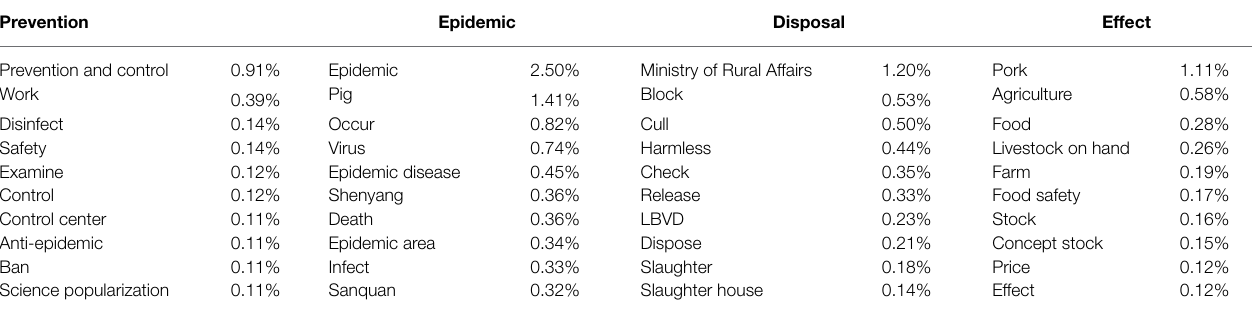
TABLE 2 | Classification and statistics for the key words.